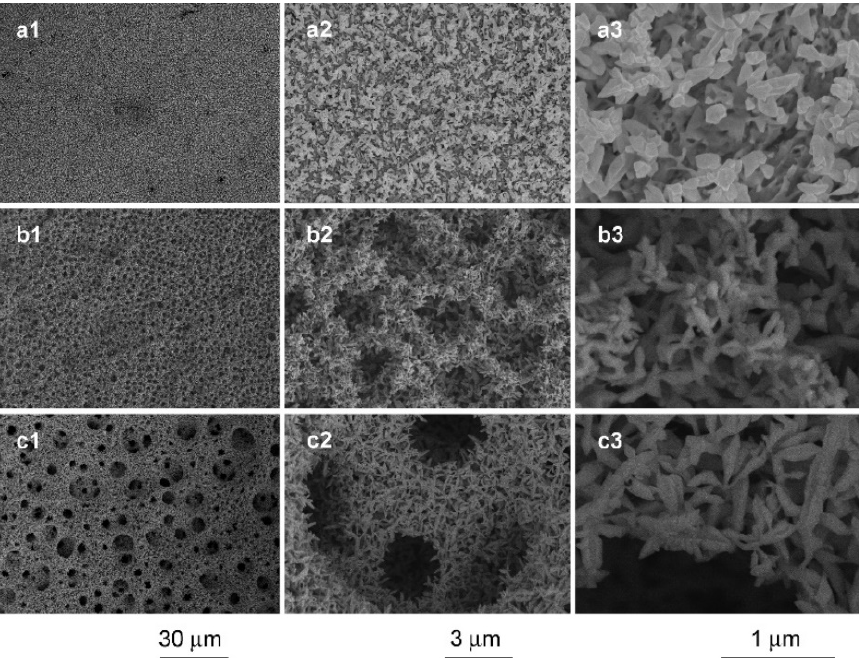
Figure 4. SEM images at different magnification scales for the PGF samples prepared using the tech- nique of square-wave potential pulse in 2 M NaOH between the potential window of 0.8 and − 5 V for different times: ( a1 – a3 ) 100 s, ( b1 – b3 ) 3000 s, and ( c1 – c3 ) 12,000 s (adapted with permission from [33], copyright 2009 American Chemical Society).